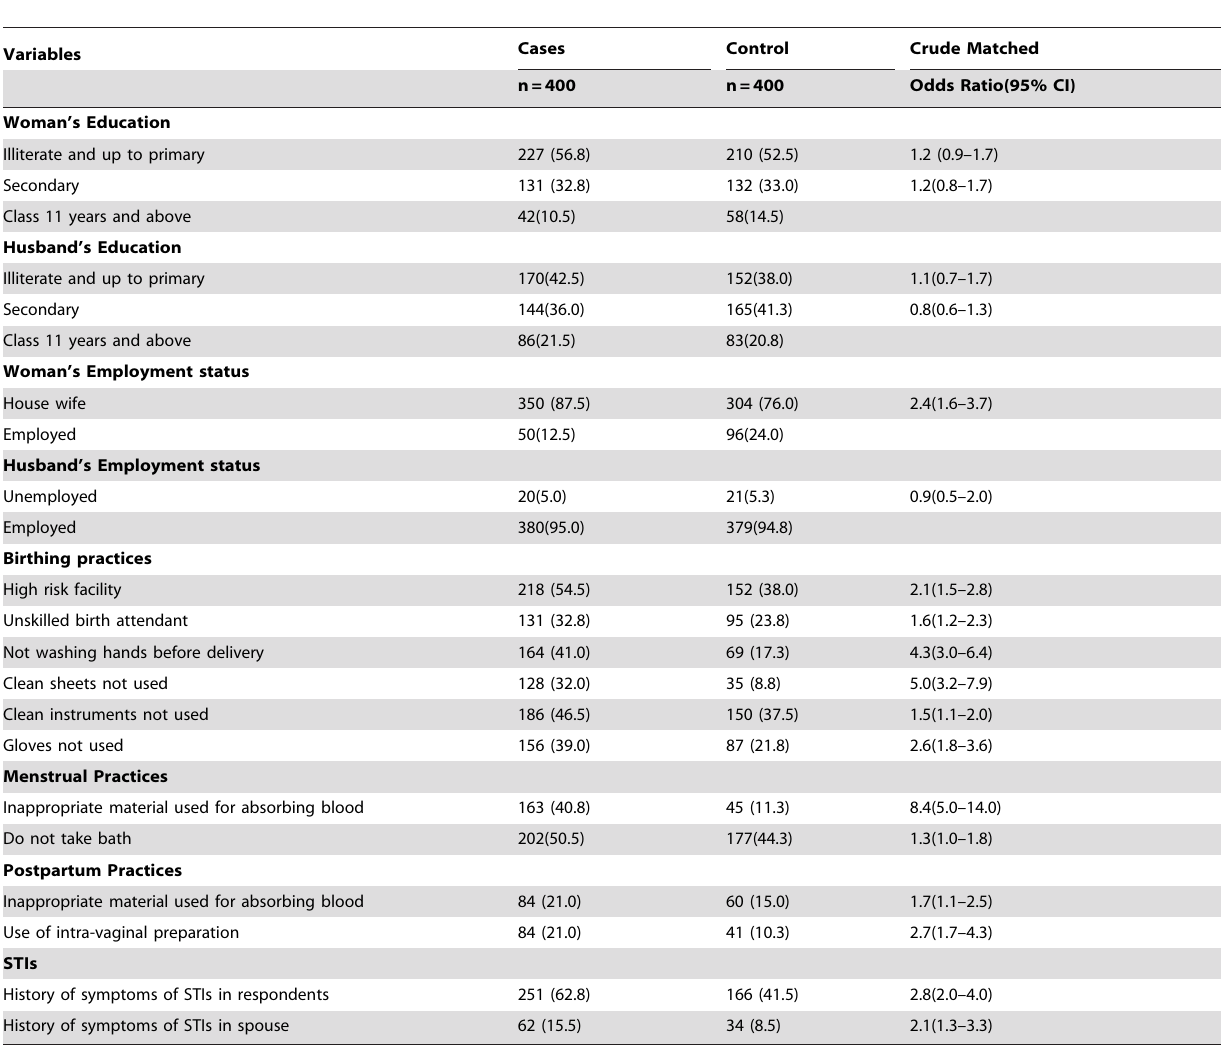
Table 2. Univariate matched Odds Ratio (OR) and their 95% Confidence Intervals (CI) for risk factors evaluated for their possible association with secondary infertility in Pakistan (adjusted for age and area of